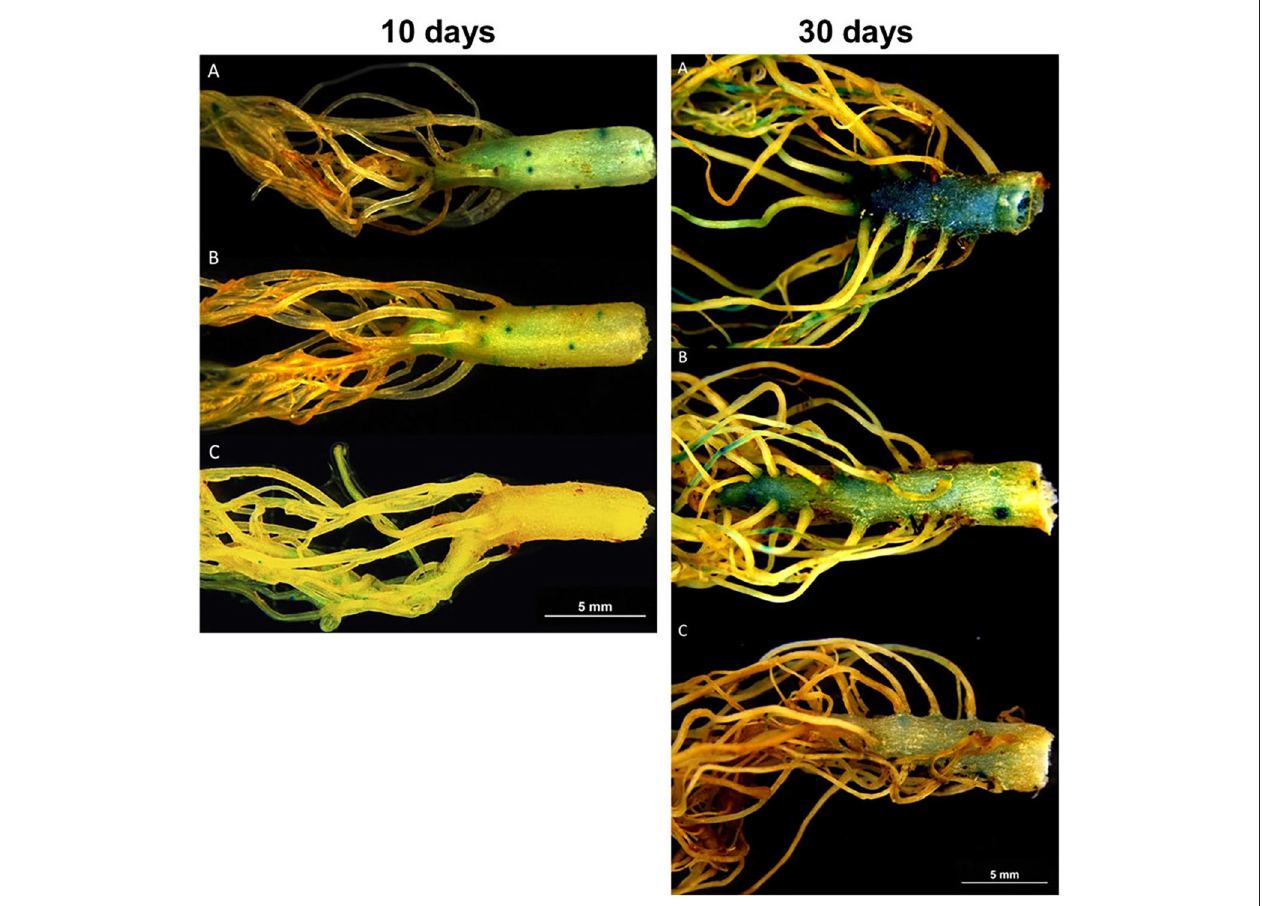
FIGURE 6 | Representative photographs of β -Glucuronidase (GUS) histochemical staining assay in MT-DR5::GUS, at 10 and 30 days after inoculation with fungal endophytes. Blue stains indicate the specific sites where auxin (IAA) accumulated in the plant tissues as revealed by the histochemical staining with X-Gluc. Seedlings at age 18–21 days were individually inoculated with Metarhizium robertsii (A) , Metarhizium humberi (B) , or non-inoculated control (C)